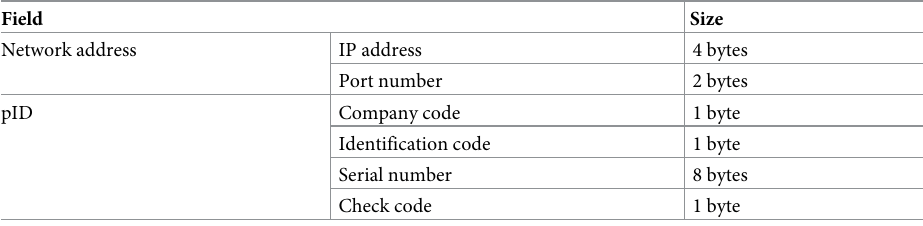
Table 2. Fields of the unique